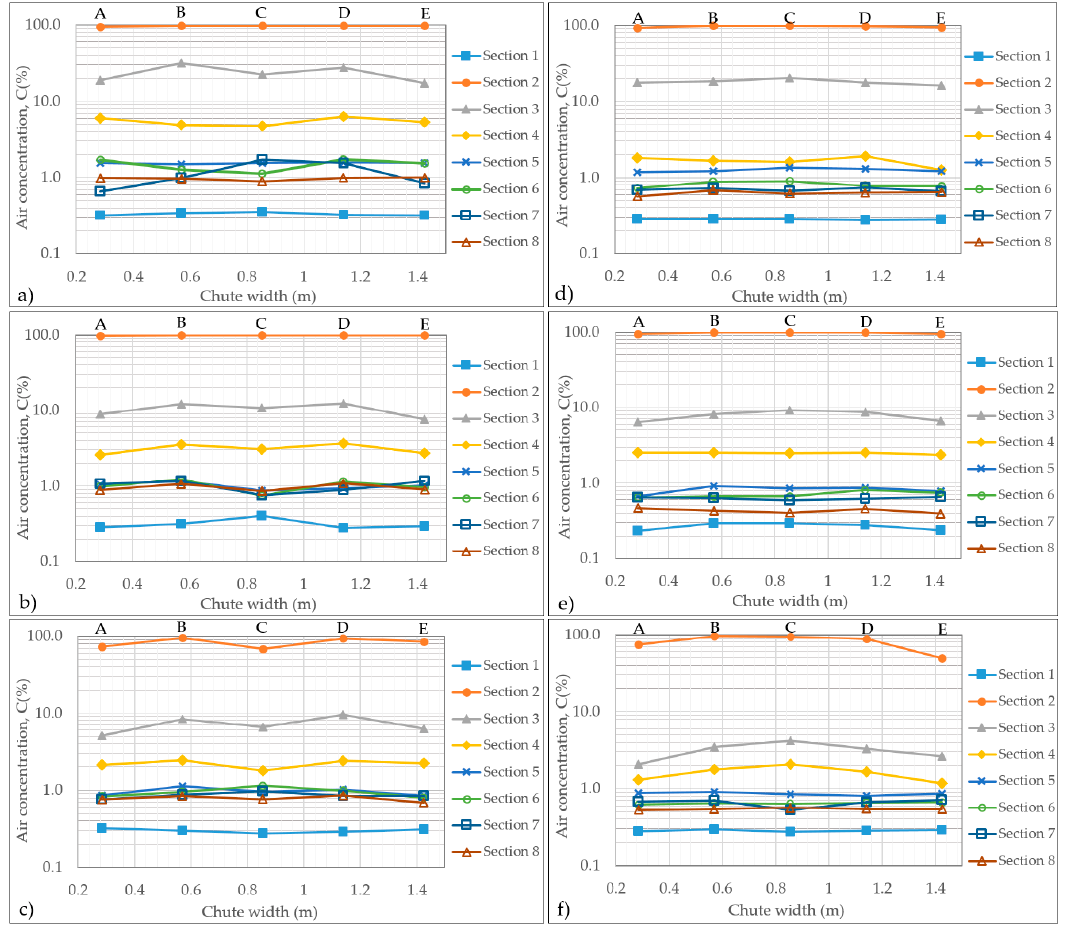
Figure 7. Bottom air concentration across the chute width at the eight sections, ( a ) 500 L/s with pier, ( b ) 1000 L/s with pier, ( c ) 1500 L/s with pier, ( d ) 500 L/s without pier, ( e ) 1000 L/s without pier, ( f ) 1500 L/s without pier.